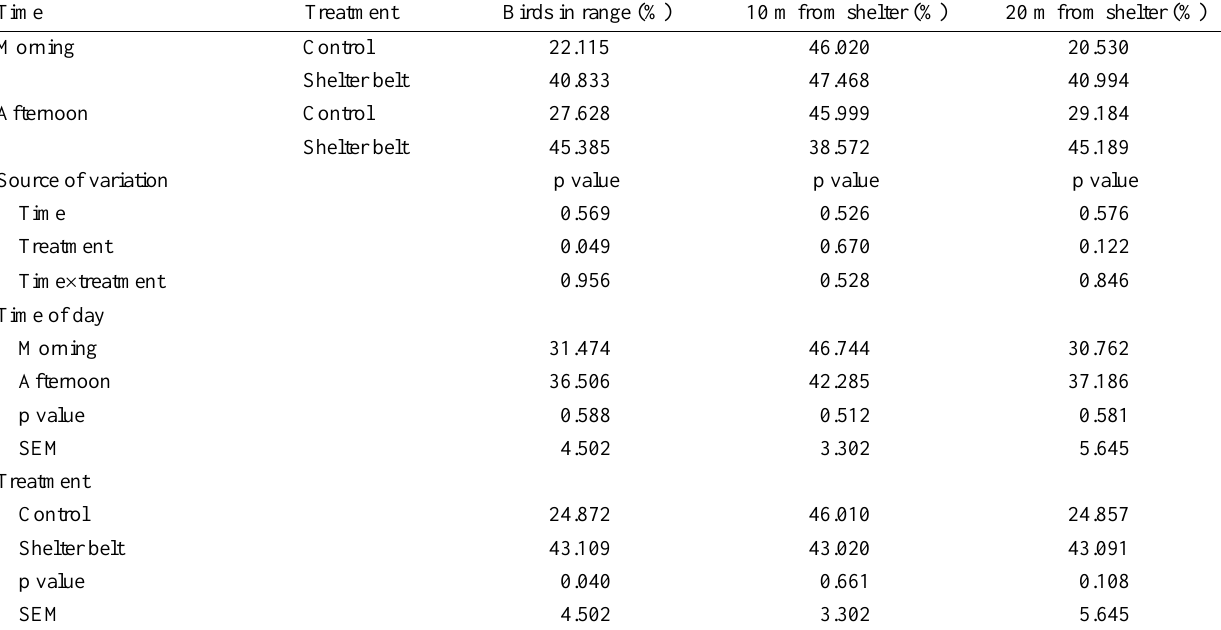
Table 2. The % of birds in range when provided a shelterbelt or no shelterbelt in the range